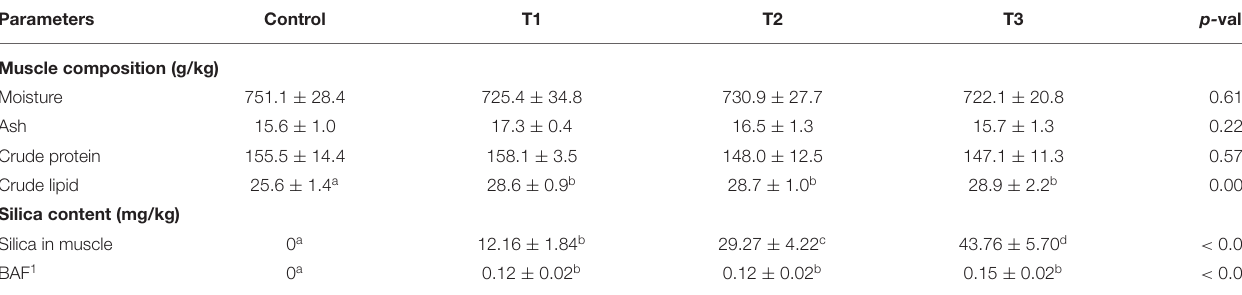
TABLE 5 | Final muscle composition of experimental tilapia in the recirculatory aquaculture system (RAS) and bioaccumulation of silica NPs. Parameters Control T1 p- value Muscle composition